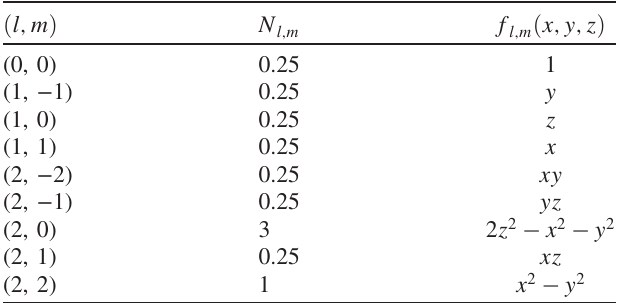
TABLE IV. Cartesian expansion of f